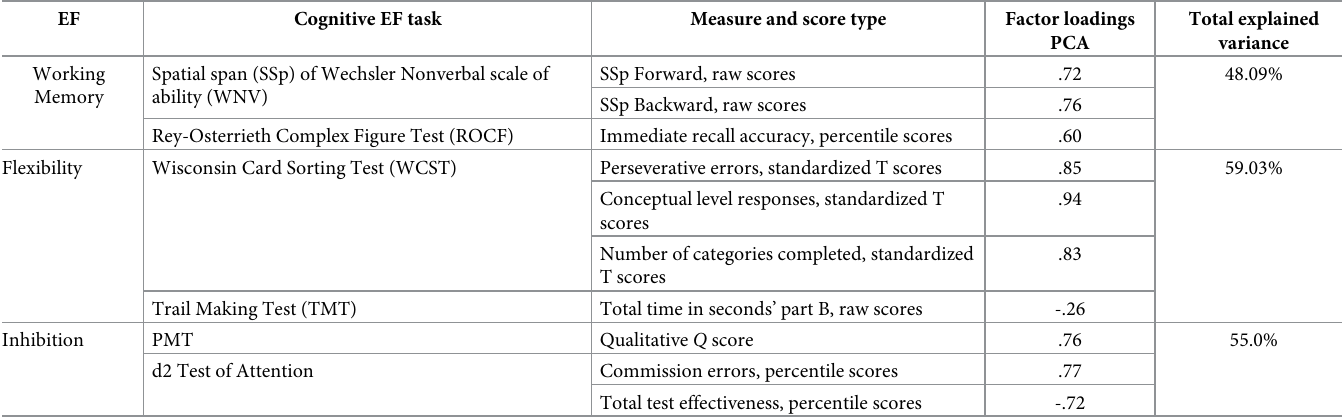
Table 1. Summary of performance-based EF